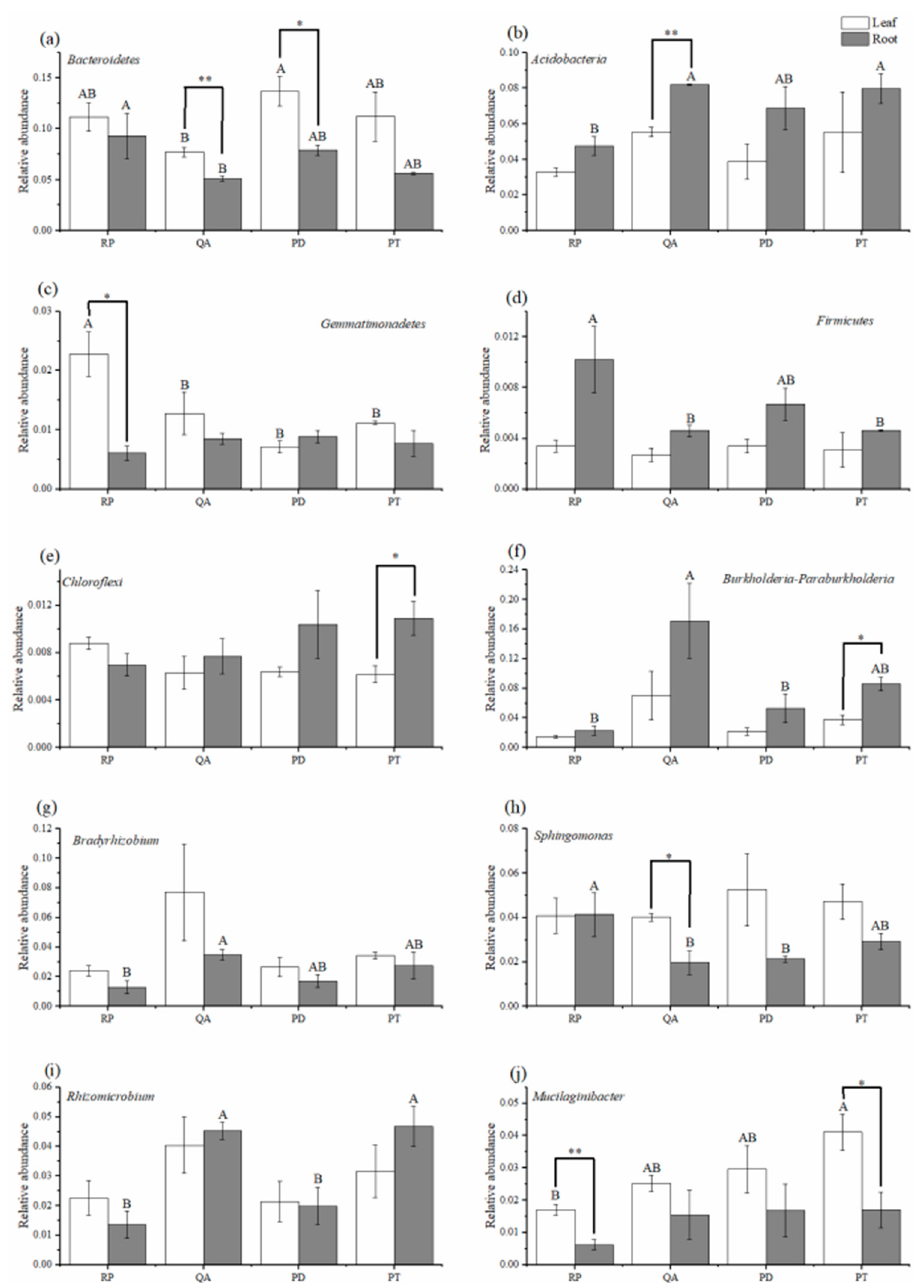
Figure 4. Differences in the relative abundances of the top ten dominant bacterial phyla ( a – e ) and genera ( f – j ) at Mount Tai. RP: R . pseudoacacia , QA: Q . acutissima , PD: P. densiflora and PT: P . tabulaeformis . Different capital letters represent significant differences among different species for the same organ ( p < 0.05). Asterisks indicate significant (* p < 0.05 and ** p < 0.01) differences between the leaf litter and fine root for the same species. All data are expressed as the mean ± SE.